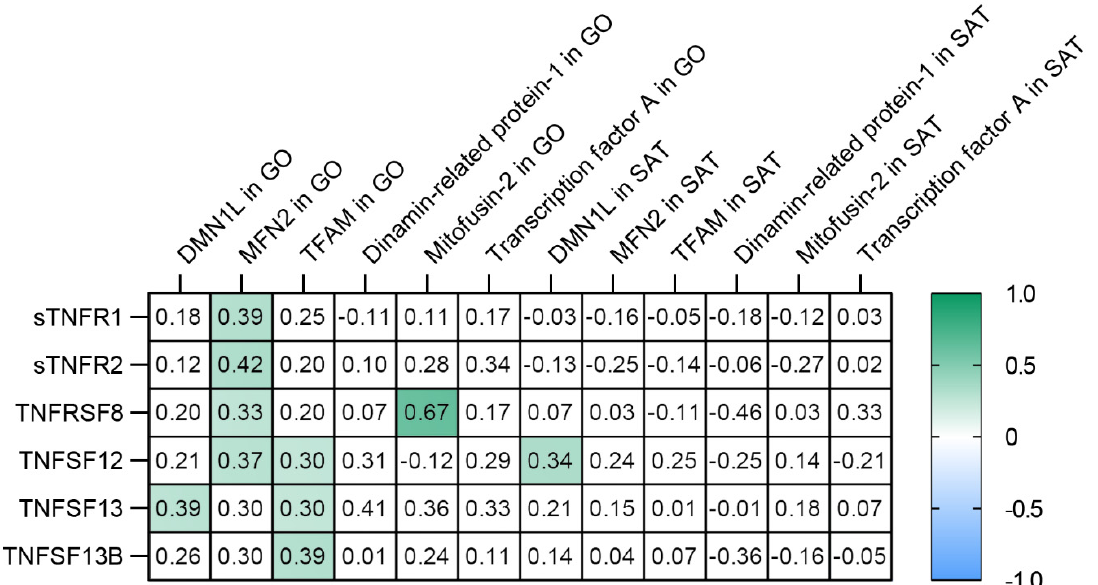
Figure 10. Correlations of sTNF-R1, sTNF-R2, sTNFRSF8 and ligands—TNFSF12, TNFSF13, TNFSF13B—with mitochondrial dynamics in all obese patients. Filled squares show significance ( p < 0.05).